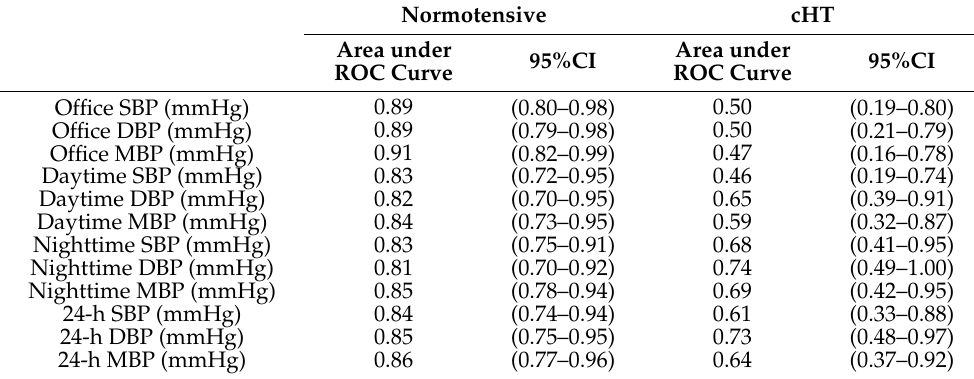
Table 6. Area under ROC curve (95%CI) of BP parameters for the subsequent development of PE in normotensive and hypertensive pregnant women.